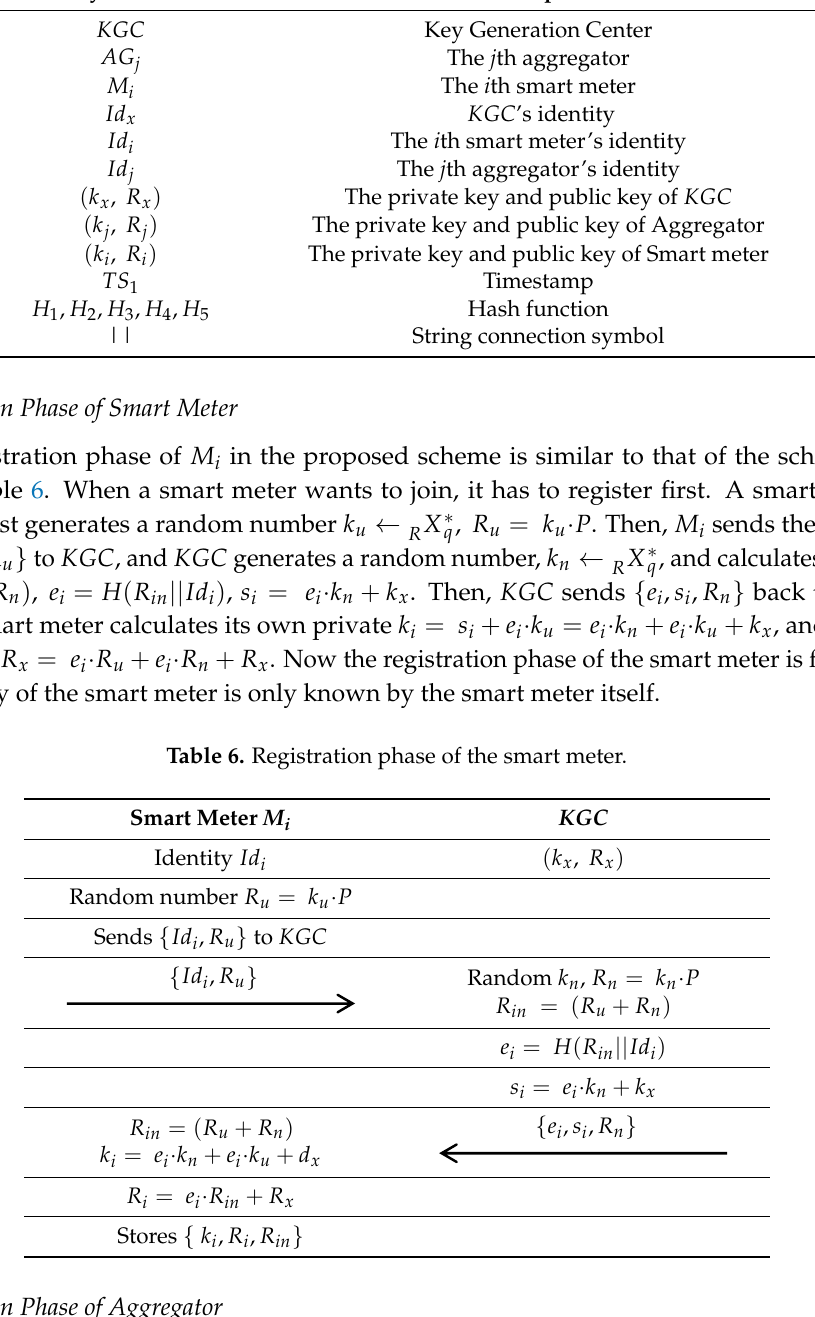
Table 5. Symbols used in the proposed scheme.